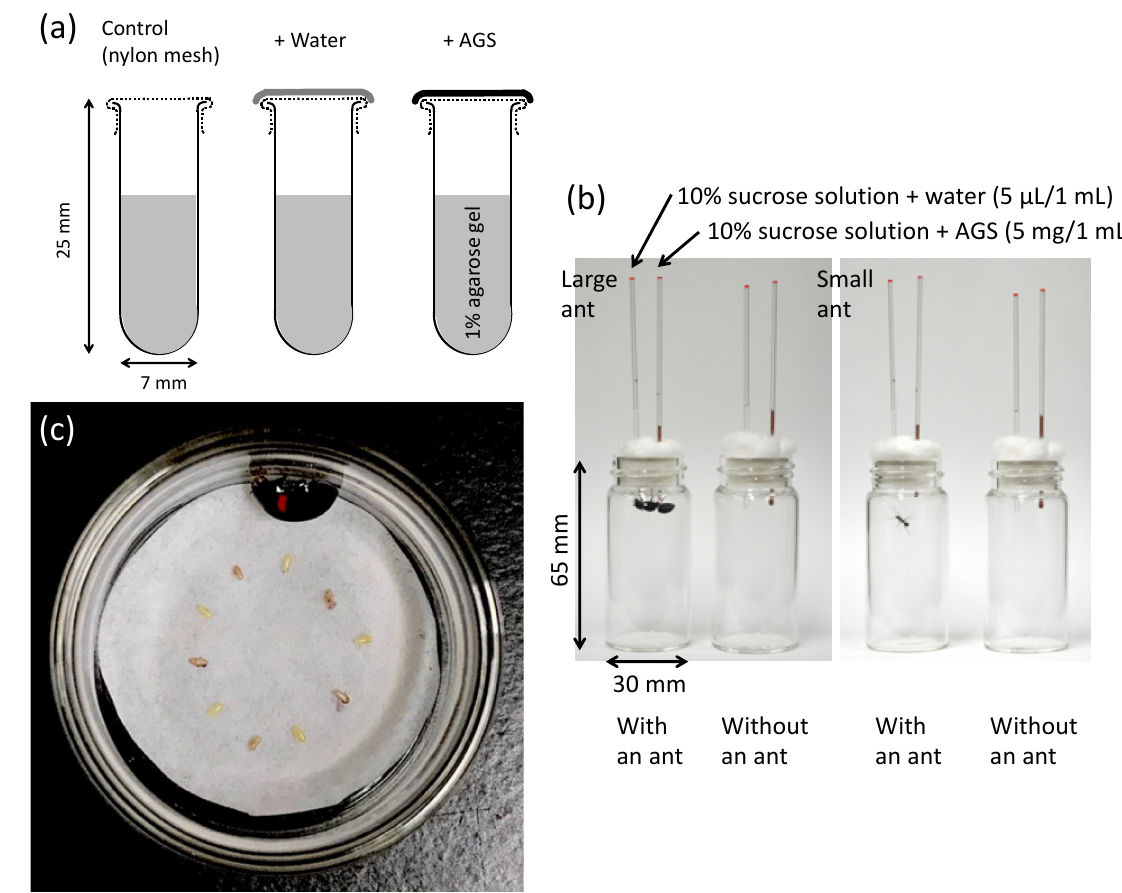
Figure 1. ( a ) The glass tubes containing 1% agarose gel used to examine the effects of female accessory gland substances (AGS) on desiccation rates. The entire opening of the tube was covered with nylon mesh only (control), nylon mesh + water (control for AGS dissolved in distilled water if partly dried), and nylon mesh + AGS. ( b ) Glass vessels used to assess the preference for 10% sucrose solution, with and without AGS in the glass capillaries, of the large and small ant species Camponotus japonicus and Formica japonica . ( c ) Egg choice of five coated (pale brown) and five uncoated (whitish) eggs with AGS of the egg-eating ladybird beetle Harmonia axyridis . The beetle was placed in a Petri dish (26 mm inner diameter) for 24 h.